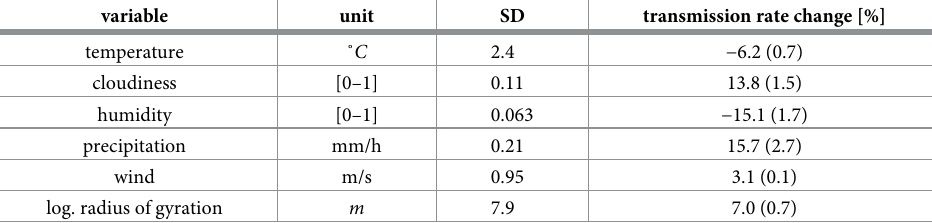
Table 1. Summary of effects of meteorological and mobility time series on the transmission rate. For each variable we give its unit, the standard deviation (SD) of the input time series and the percent change with its weighted SD of the transmission rate associated with a unit SD change in the input.